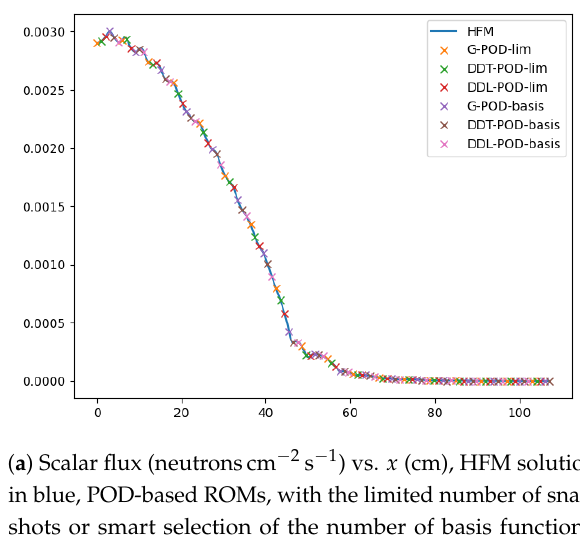
Figure 13. Scalar flux for Energy Group 1 for the HFM (blue) and POD-based ROMs, with the limited number of snapshots or smart selection of the number of basis functions, in crosses, and the pointwise error between them with parameters R 1 = 2, R 2 = 2, R 3 = 1, R 4 = 1, R 5 = 4.